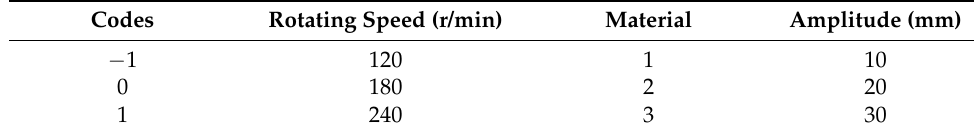
Table 1. The codes of the factors.